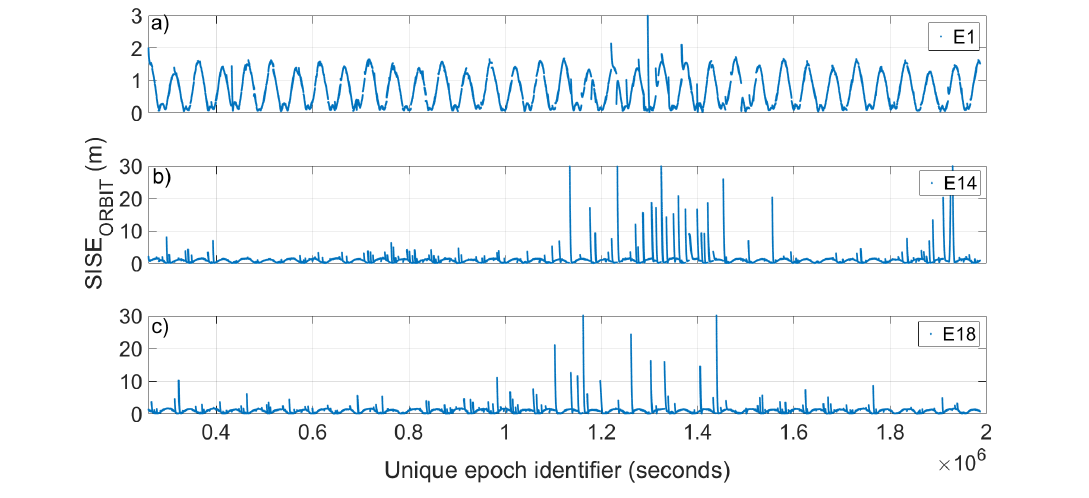
Figure 4. SISE orbit versus time obtained with an ephemeris validity time of 14,400 s (4 h). Satellite 1 (E1), Milena (E14) and Doresa (E18) are plotted in ( a – c ), respectively. To have a better representation, in ( b , c ), the maximum value of the SISE orbit shown is 30 m.